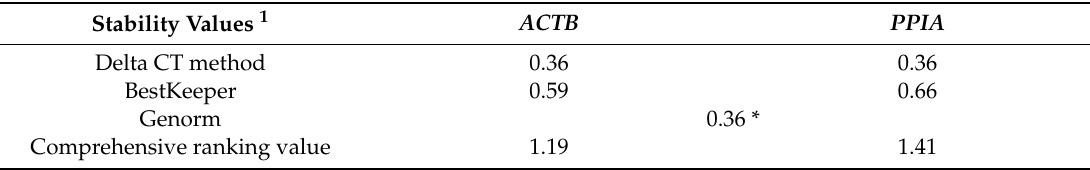
Table 3. Stability values of candidate reference genes according to three di ff erent evaluation methods used by